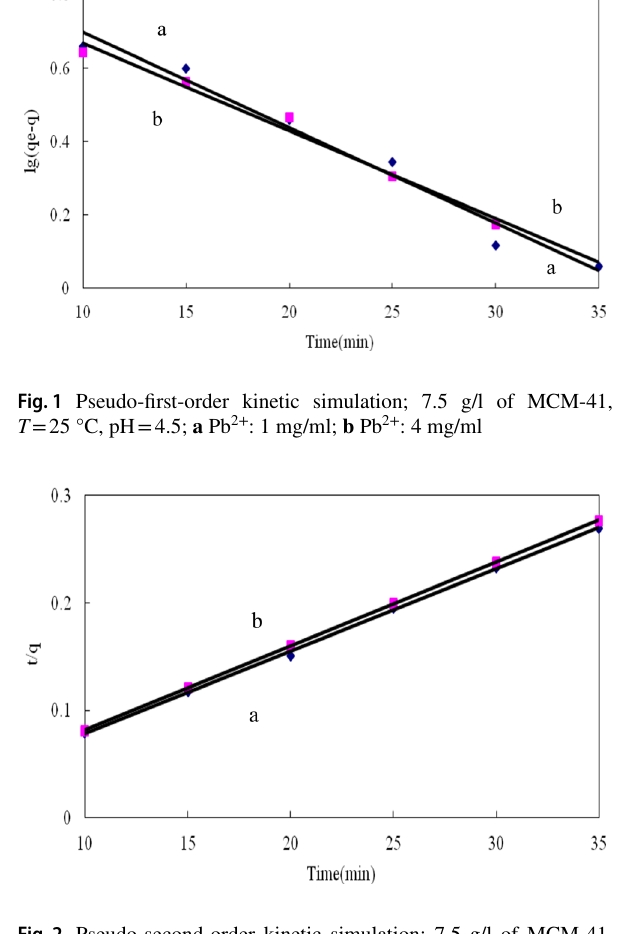
Table 1 Kinetic parameters for the adsorption of Pb 2+ onto MCM-41 Concentration Adsorption capacity determined (mg/l) by experiment q e,exp (mg/g)